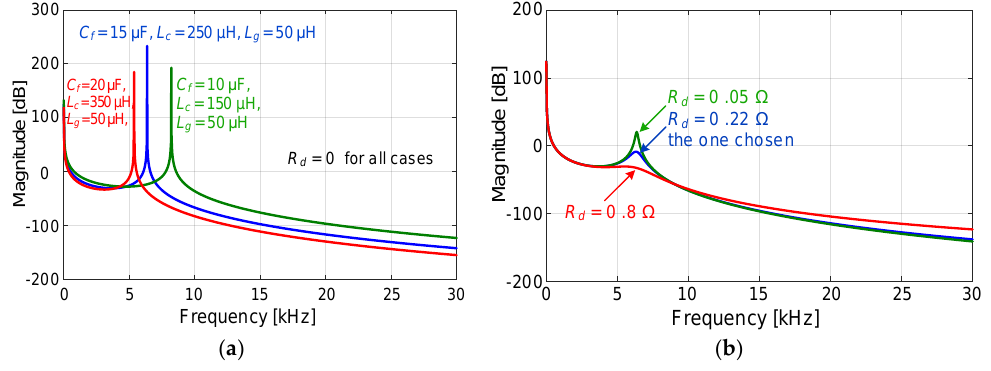
Figure 9. Transfer characteristics of various LCL filters shown in: ( a ) undamped filters, R d = 0; and ( b ) effects of R d on the transfer characteristic on the chosen LCL filter ( L c = 250 μH, C f = 15 μF, and L g = 50 μH).